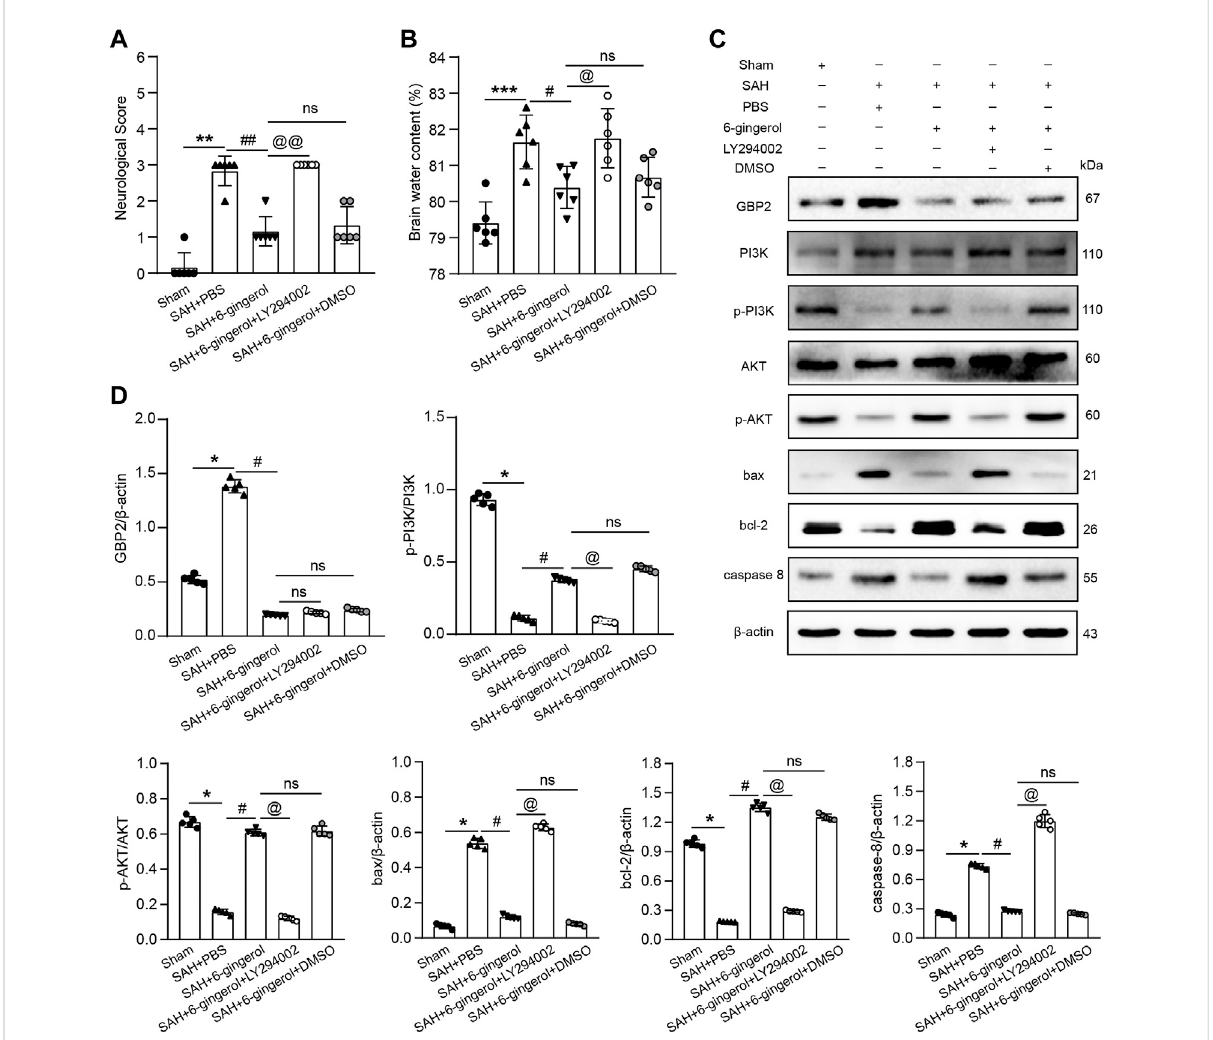
FIGURE 7 6-gingerol improves neurologic function and reduces brain edema via the GBP2/PI3K/AKT axis in SAH rats. (A) Quantitative analysis of neurological scores, n = 6, Mann-Whitney U test was used. (B) Quantitative analysis of brain water content, n = 6. One-way ANOVA was used followed by Tukey ’ s post hoc test. (C) Immunoblot analysis of GBP2, PI3K, p-PI3K, AKT, p-AKT, bax, bcl-2 and caspase 8 protein expression. (D) Quantitative western blot, n = 5. One-way ANOVA was used followed by Tukey ’ s post hoc test. * p < 0.05, ** p < 0.01, *** p < 0.001 vs sham group; # p < 0.05, ## p < 0.01 vs SAH + PBS group; @ p < 0.05, @ p < 0.01 vs SAH + 6-gingerol group; ns p = no signi fi cant vs SAH + 6-gingerol